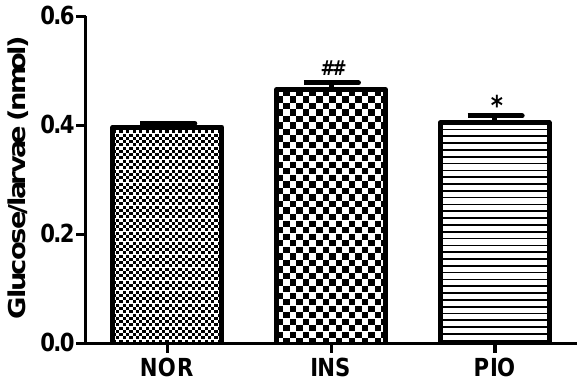
Figure 8. Free glucose level following pioglitazone (PIO) treatment in insulin-treated zebrafish. (##) p < 0.01; compared to normal (NOR). (*) p < 0.05; compared to insulin-treated group (INS).